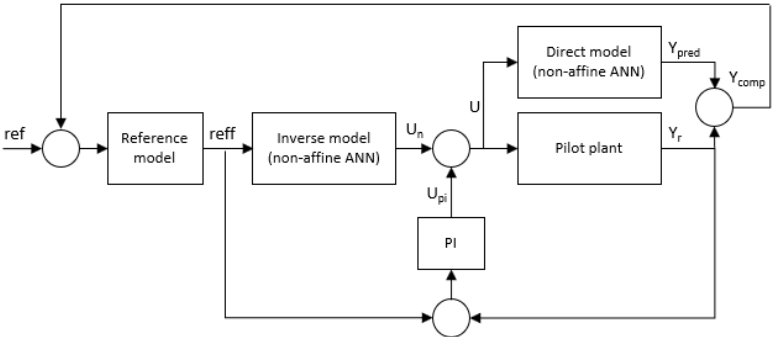
Figure 3. Direct control with reverse pre-feed based on artificial neural networks.